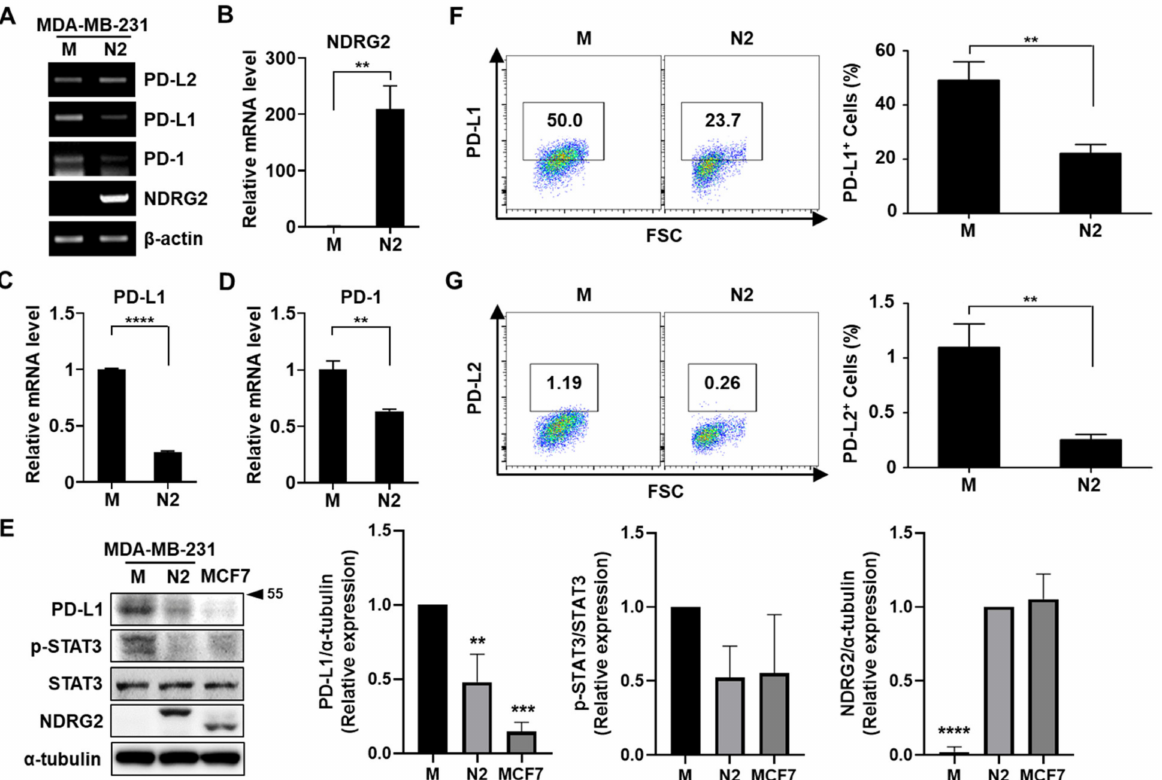
Figure 1. NDRG2 overexpression inhibits PD-L1 expression in human breast cancer cells. ( A – D ) The mRNA expression of NDRG2, PD-L1, and PD-1 in MDA-MB-231-mock (M) and MDA-MB-231-NDRG2 (N2) cells was examined by RT-PCR ( A ) and real-time PCR ( B – D ). ( E ) The protein expression of NDRG2, PD-L1, and p-STAT3 in MDA-MB-231-mock, -NDRG2, and MCF7 cells was measured by Western blot analysis. ( F , G ) MDA-MB-231-mock and MDA-MB-231-NDRG2 cells were stained with specific antibodies against PD-L1 or PD-L2 and analyzed by flow cytometry. ** p < 0.01, *** p < 0.001, and **** p < 0.0001. The uncropped blots and molecular weight markers are shown in Supplementary